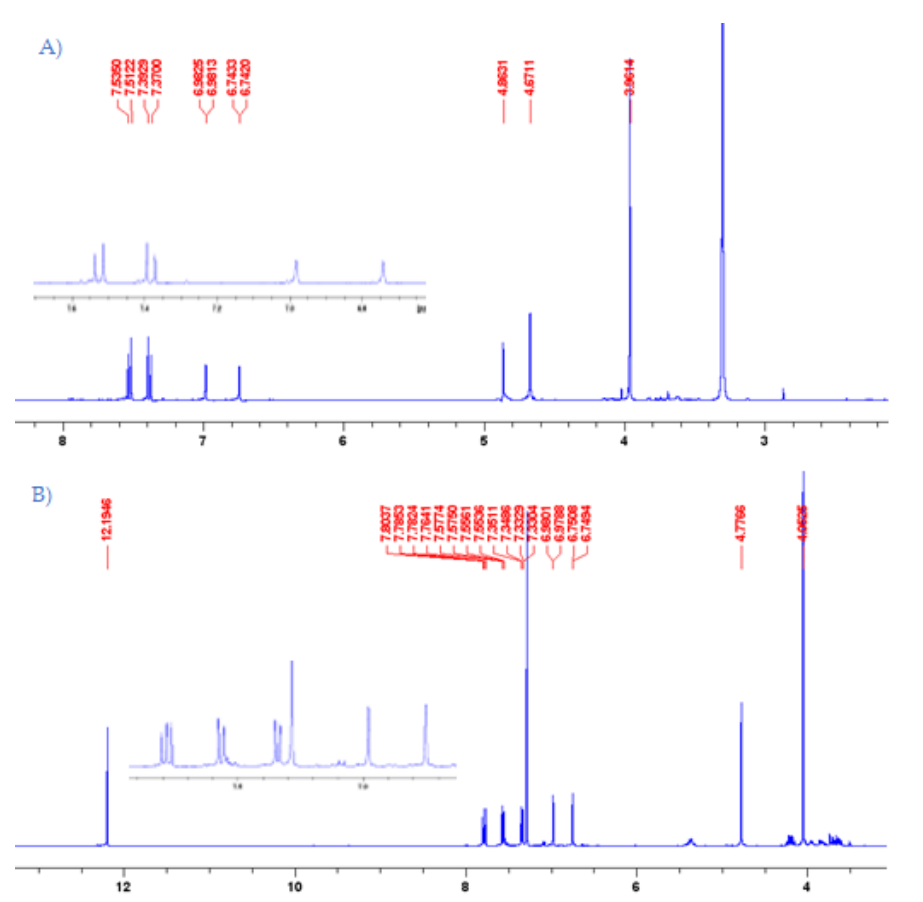
Figure 4. NMR 1 H spectrum of ( A ) Sydowinol (S1) (400 MHz, MeOD) and ( B ) Sydowinin A (S2) (400 MHz, CDCl 3 ).